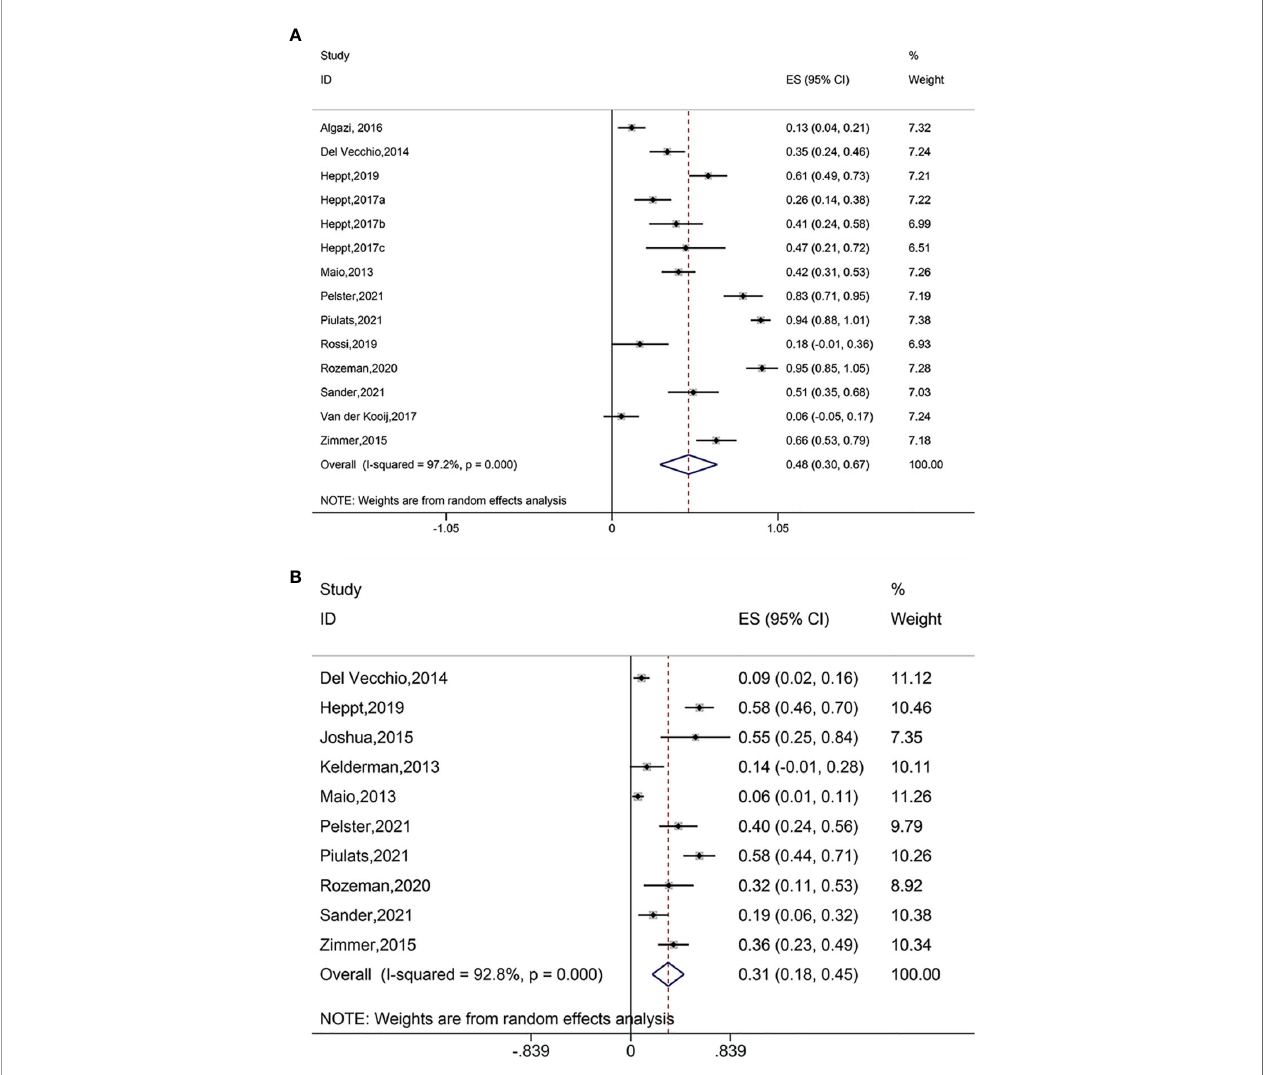
FIGURE 4 | (A) Forest plot of adverse events (AEs) after treatment with immune checkpoint blockade. (B) Forest plot of serious adverse event (SAEs) after treatment with immune checkpoint